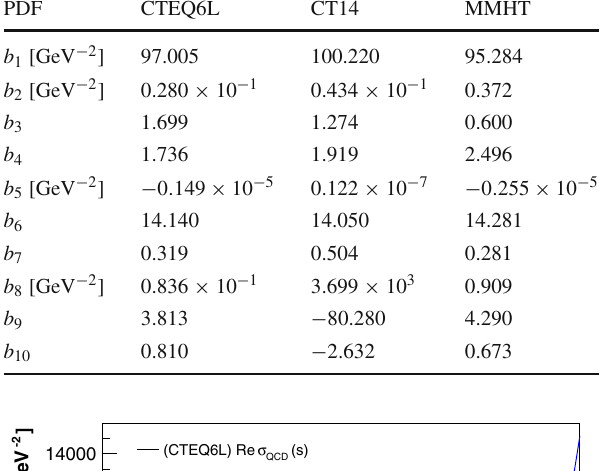
√ √ 5 and 2, respectively.